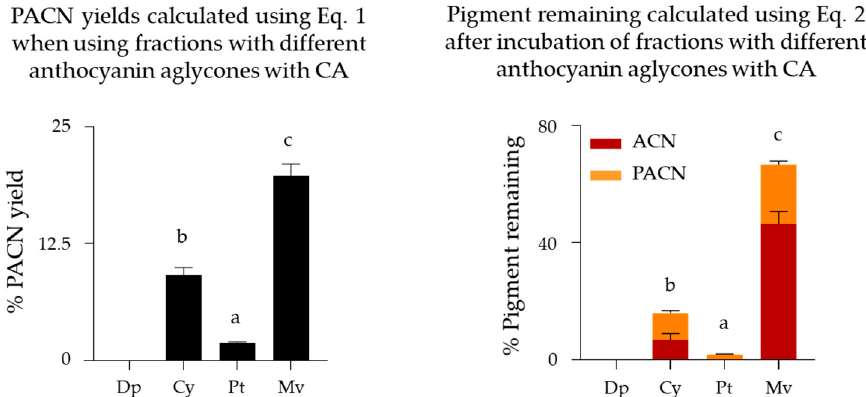
Figure 6. Pyranoanthocyanin yield (%PACN) and pigment remaining (%) after incubation of anthocyanin fractions with different aglycones with caffeic acid (CA) for 24 h at 45 °C. Different letters show significant differences among different fractions at a 0.05 level. Results are expressed as mean ± standard error ( n = 3). ACN: anthocyanin, Dp: delphinidin-derivatives fraction, Cy: cyanidin-derivatives fraction, Pt: petunidin-derivatives fractions, Mv: malvidin-derivatives fraction, Eq: equation.